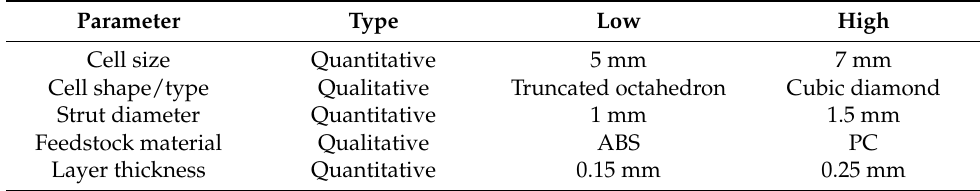
Table 1. Levels for the factorial analysis.